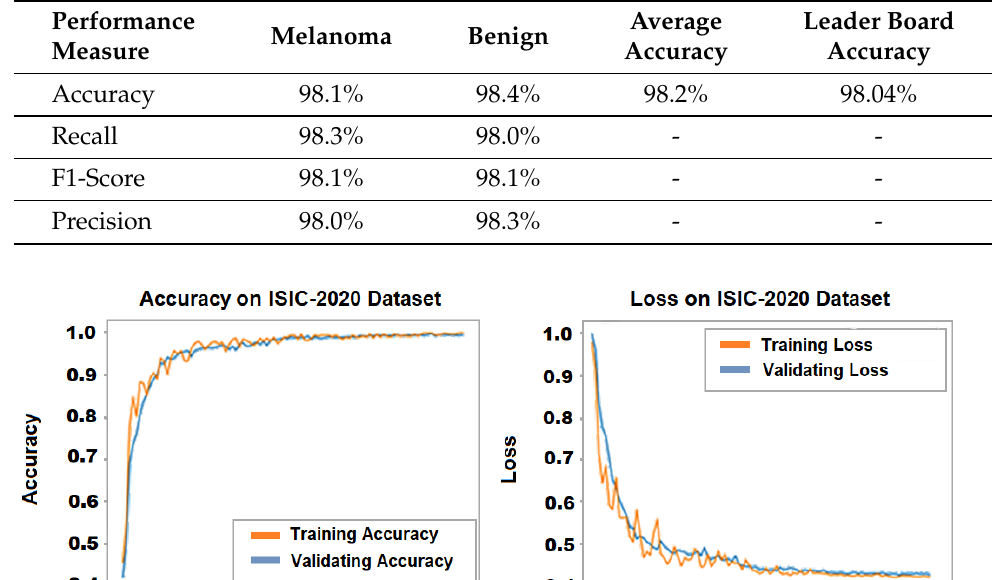
Table 5. Classification accuracies, recall, precision and F1-score of presented MobileNetV2 Model on ISIC-2020 dataset.